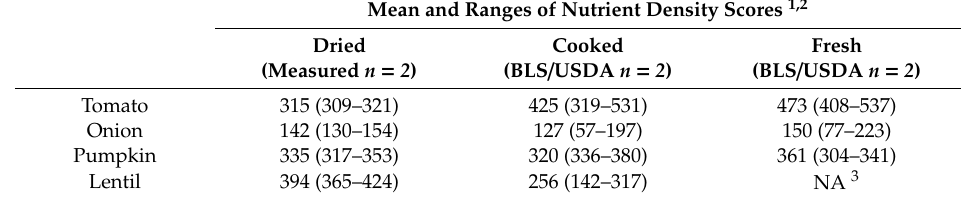
Table 2. Nutrient density scores for dry vegetable powders as compared to respective cooked and fresh